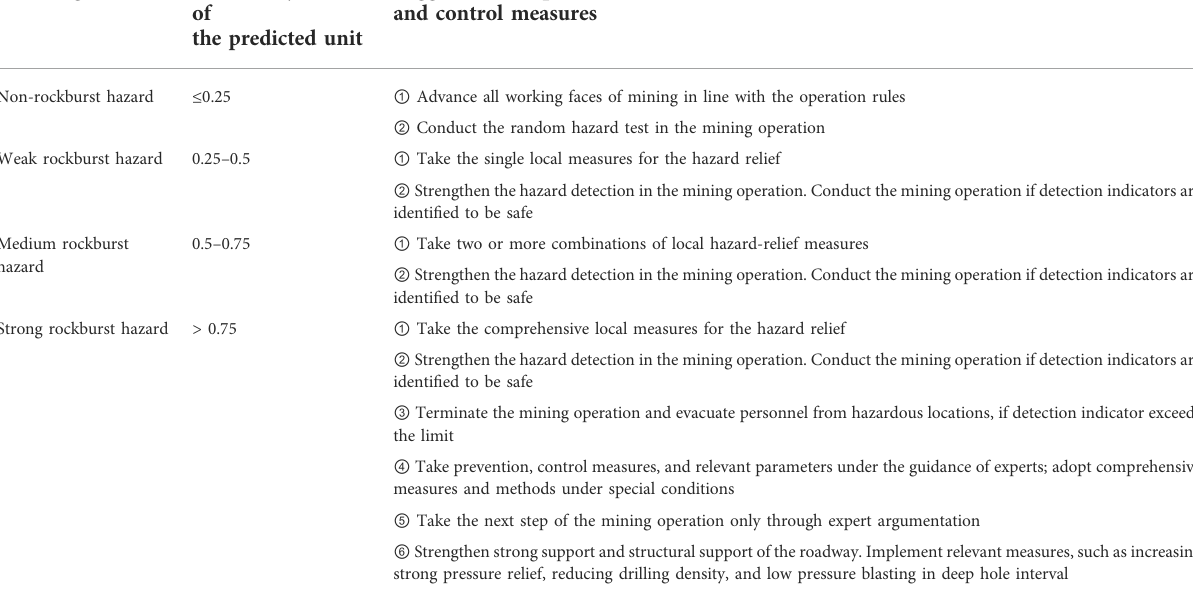
TABLE 2 Hazard classi fi cation of rockburst and prevention measures in Jixian Coal